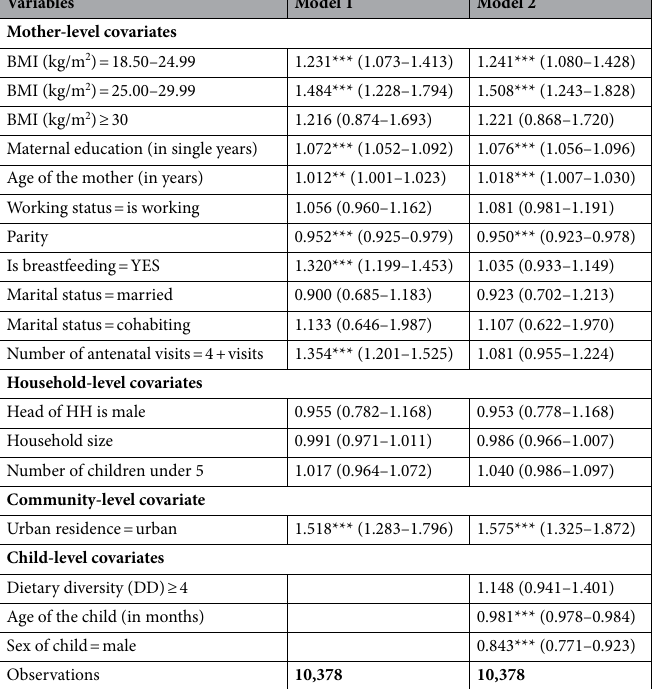
Table 6. Multivariable analysis of the effects of socio-demographic factors on better linear growth/non- stunting among children living in poor households in Nigeria. Significant values are in bold. 95% confidence intervals (CIs) in parentheses. DD dietary diversity, HH household, BMI body mass index. *** p < 0.01, ** p < 0.05, * p <